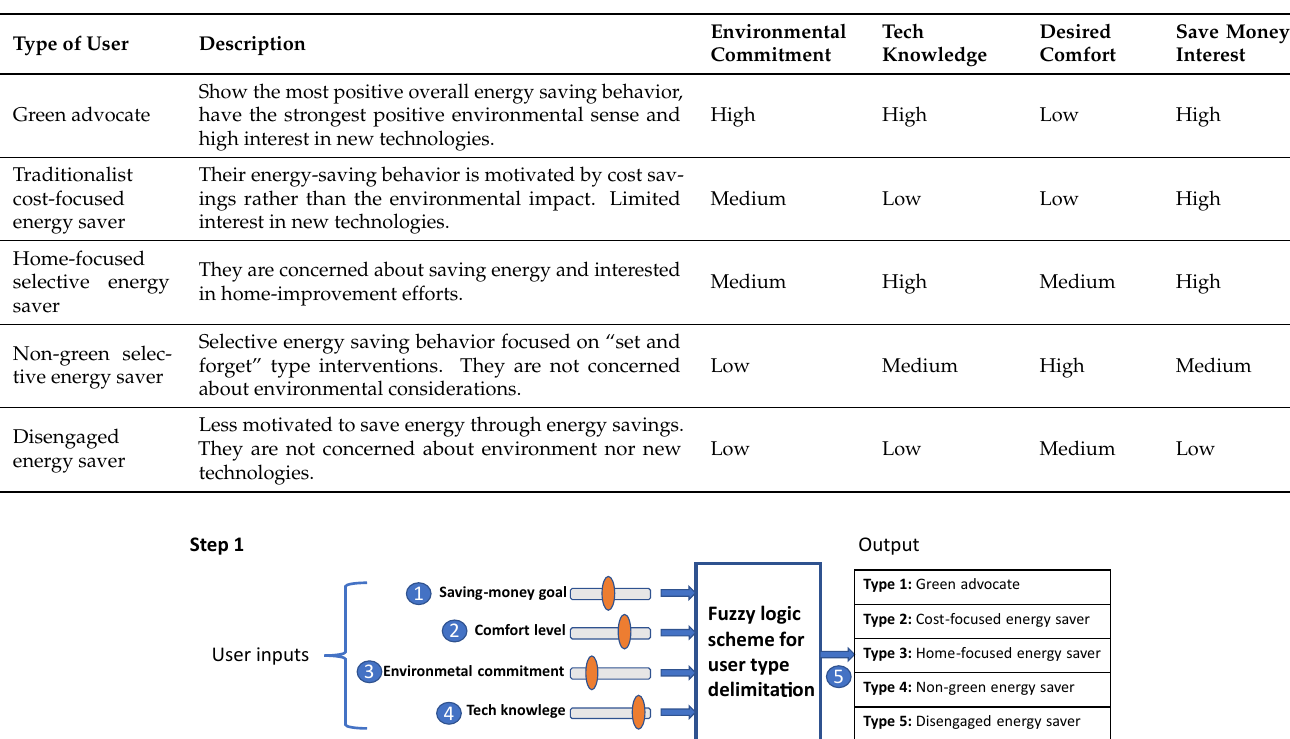
Table 2. Classification user scheme.